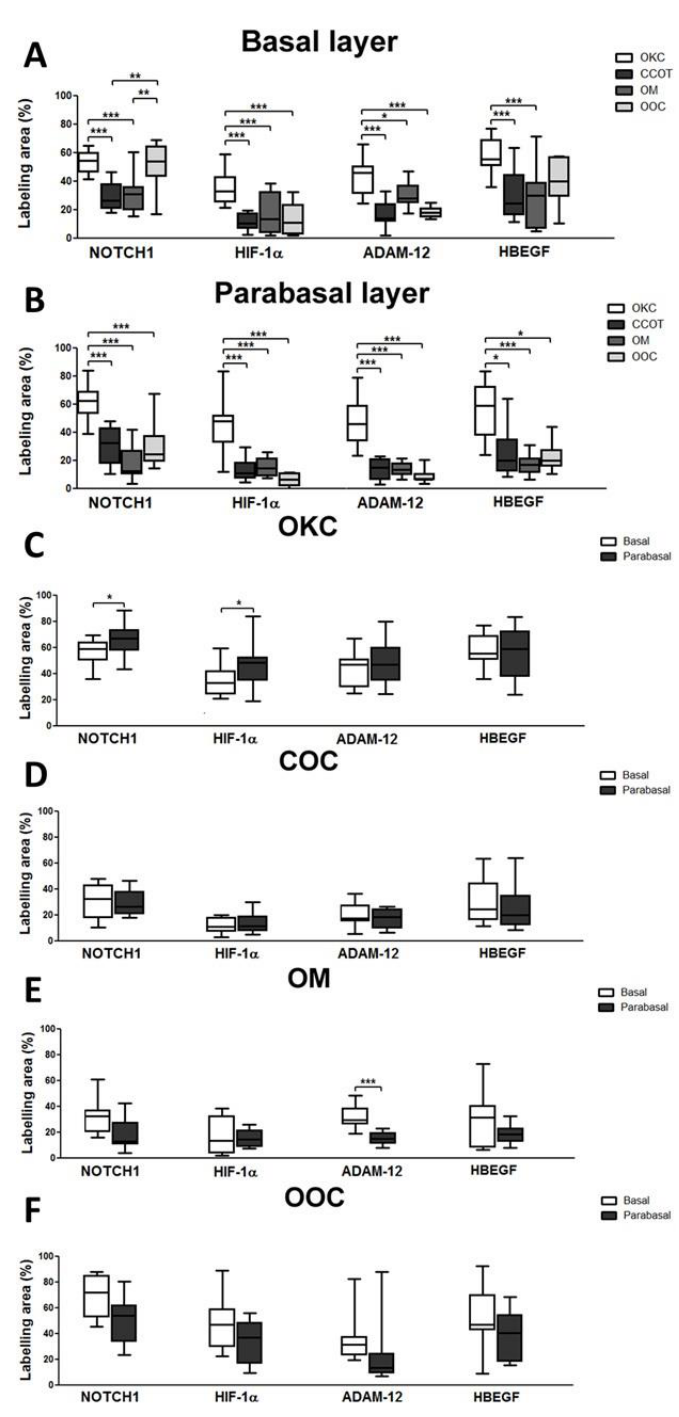
Figure 5. Comparison of NOTCH1, HIF-1 α , ADAM-12, and HBEGF immunolabelling in basal ( A ) and parabasal ( B ) layers between OKC, COC, OM, and OOC. OKC overexpressed all the studied protein when compared to COC, OM, and OOC in either basal ( A , except for NOTCH1 and HBEGF in OOC) and parabasal ( B ) layers. Immunoexpression between basal and parabasal layers within the same lesions was also evaluated in OKC ( C ), COC ( D ), OM ( E ), and OOC ( F ). Di ff erences were only seen for NOTCH1 and HIF-1 α in OKC and ADAM-12 in OM. In OKC, NOTCH1, and HIF-1 α were more expressed in parabasal layers, while ADAM-12 in OM showed a higher expression in the basal layer. * p < 0.05; ** p < 0.01; *** p < 0.001.